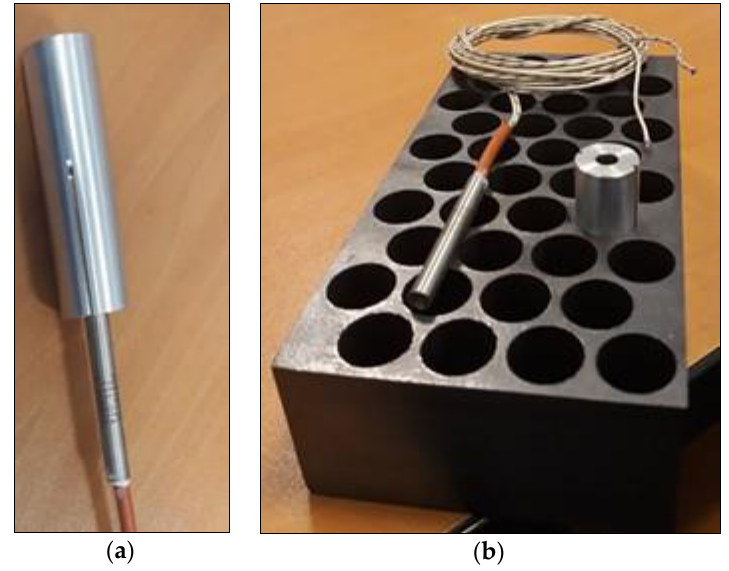
Figure 11. ( a ) Aluminum 10 W heating element and ( b ) the PCM-graphite matrix with the holes for the heating elements.